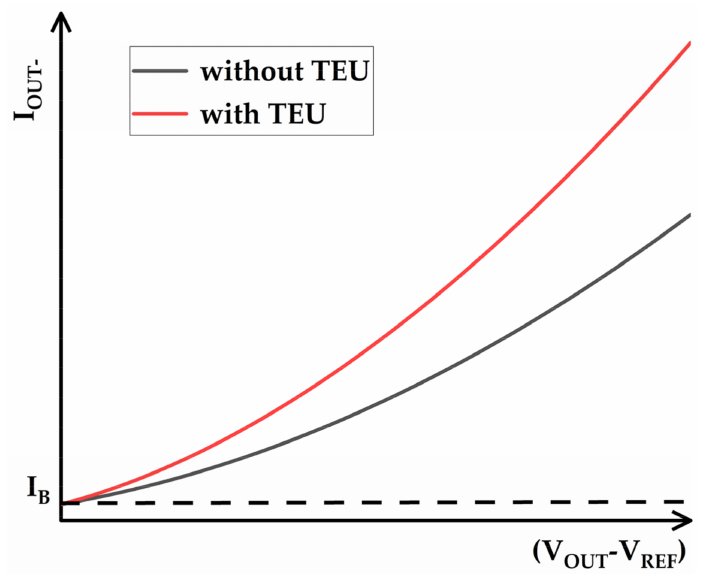
Figure 3. The output currents of the Gm cells with TEU and without